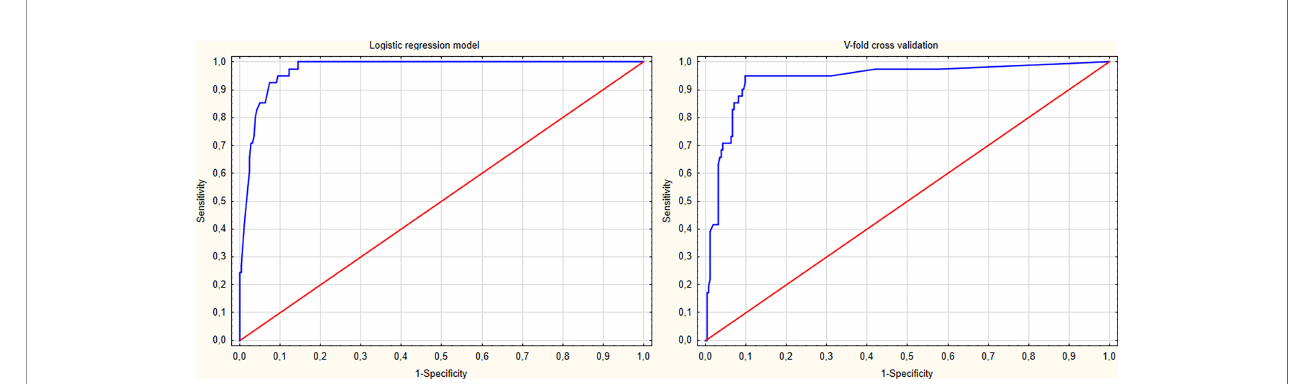
FIGURE 2 | The receiver operating characteristic (ROC) curves of the proposed logistic regression model and the v-fold cross validation of the model.